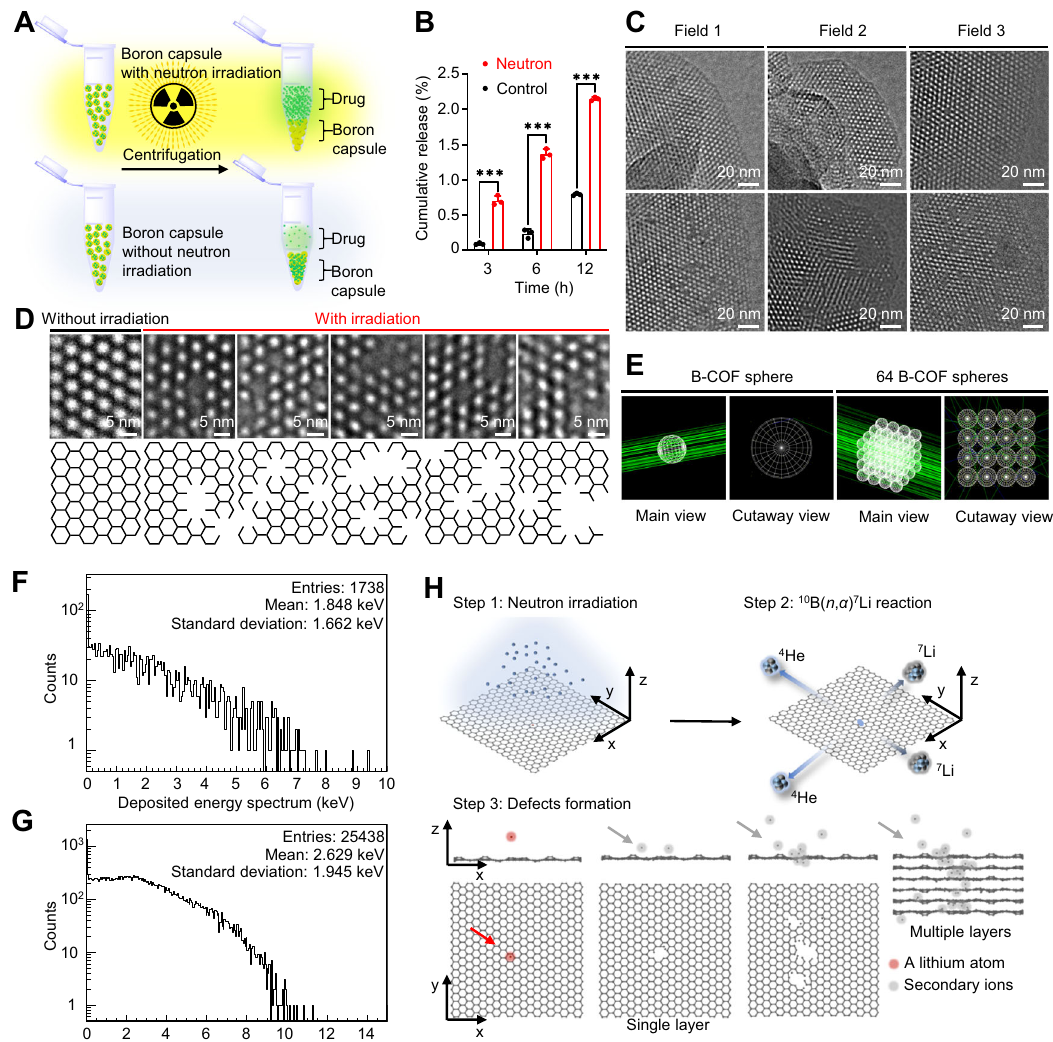
Fig. 2 | Defects induced by neutron capture nuclear reaction accelerate the drug release from the boron capsule. A Work fl ow of assaying drug release from neutron-activated boron. Boron capsule in phosphate-buffered saline (PBS, pH = 7.4)was exposed to thermalneutron irradiation for 30min with a thermalneutron fl ux of 1.9 × 10 9 /(cm 2 ·s). The released drug (i.e. imiquimod) was isolated by cen- trifuge and then determined by ultra-performance liquid chromatography-mass spectrum (UPLC-MS). B In vitro drug release pro fi le of boron capsule in PBS at 37°C. Data are shown as mean±SD. ( n =3 independent experiments, two-tailed unpaired Student ’ s t -test, P value <0.0001). C TEM images of B-COF before (top) and after (bottom) thermal neutron irradiation ( n =3 samples). Notable defects were observed after irradiation. D Representative enlarged TEM images (top) and